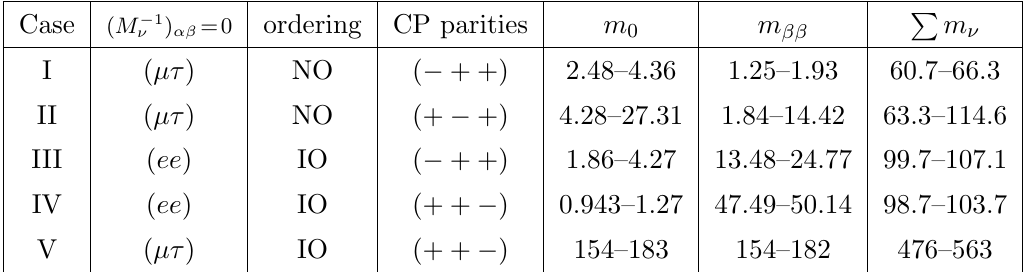
Table 1 . Possibilities for one-zero textures with predictions for the lightest neutrino mass ( m 0 ), neutrinoless double beta decay e(cid:11)ective mass ( m (cid:12)(cid:12) ) and sum of neutrino masses; all masses are in